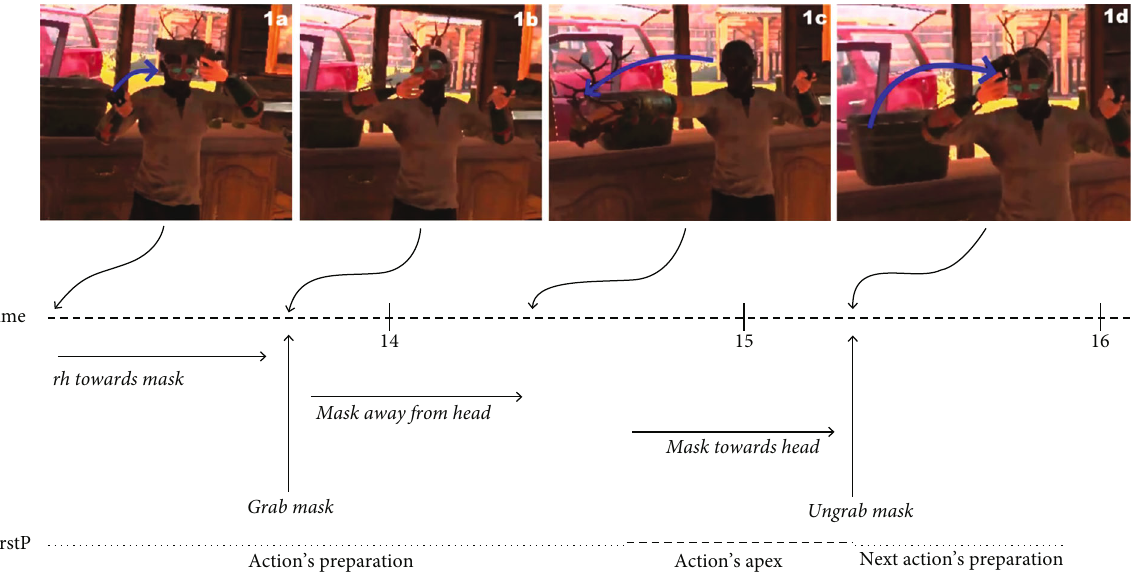
Figure 10: Removing and reequipping the mask. “ This is how you put on the mask ” . Time in